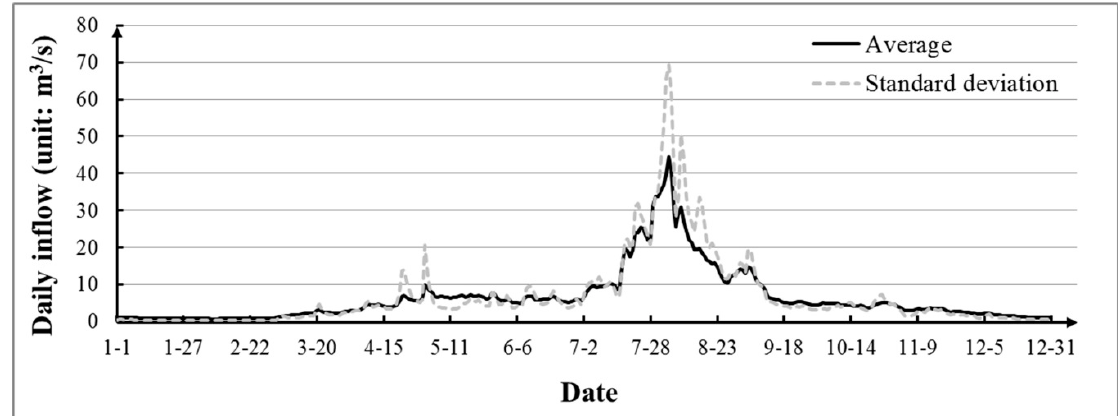
Figure 3. Averages and standard deviations of daily inflow to the Tanghe Reservoir.